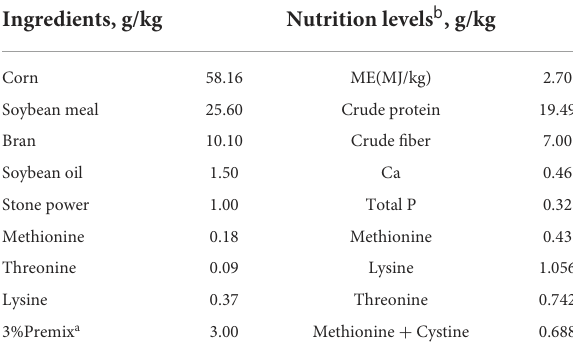
TABLE 1 Ingredients and composition of basal diets (DM basis) %.